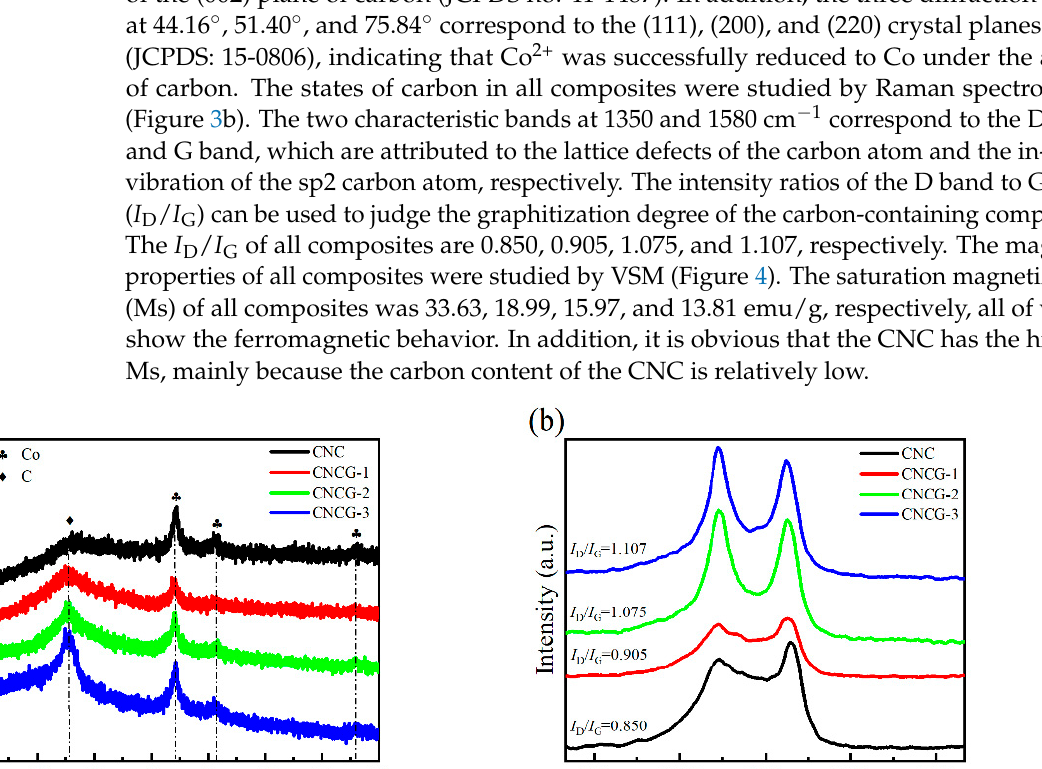
Figure 2. The HR-TEM image of CNC.